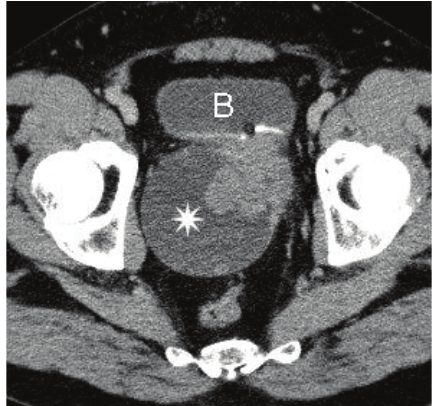
Figure 2: CT of the pelvis, enhanced axial image. The asterisk is on the cystic component of the mass. The arrow shows the solid part of the lesion. B =